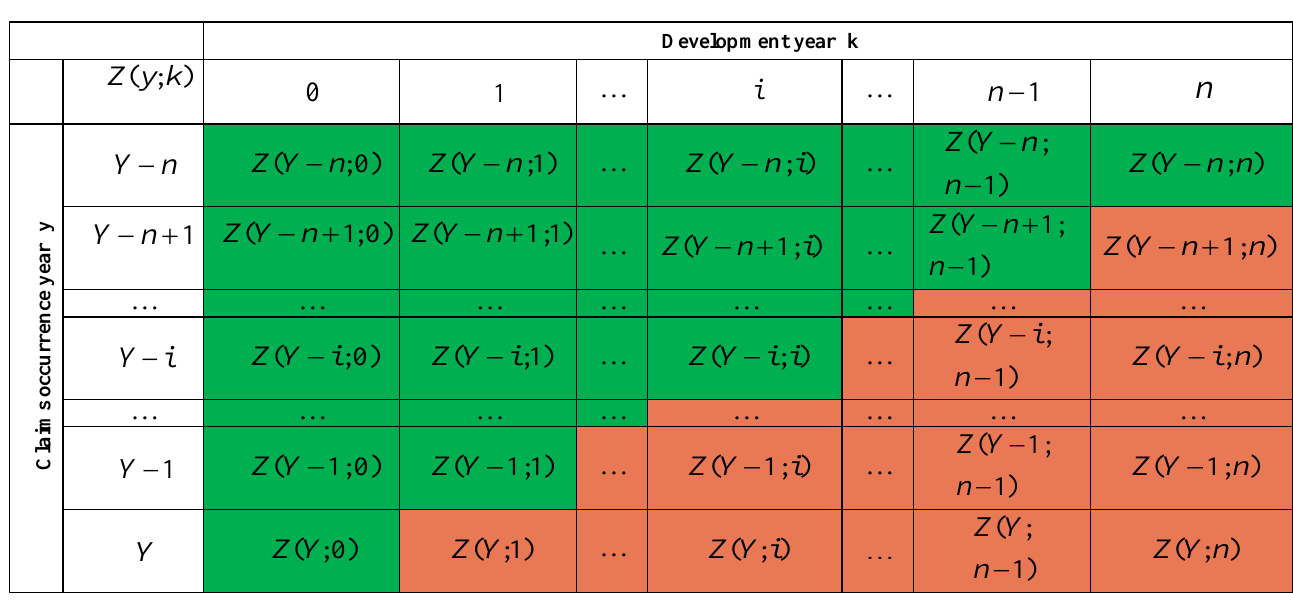
Fig. 1. Incremental claims loss settlement data represented as a run-off